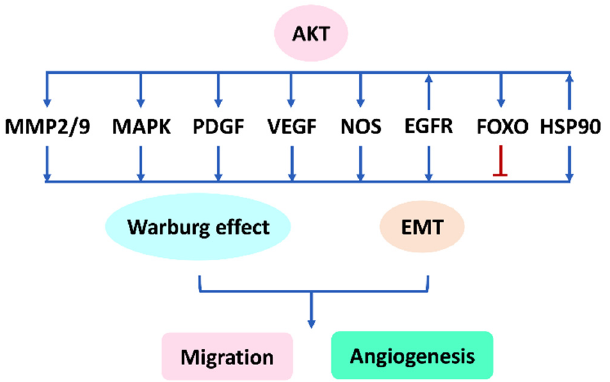
Figure 2. AKT signaling network affects migration and angiogenesis. This flow chart summarizes Sections 1 to